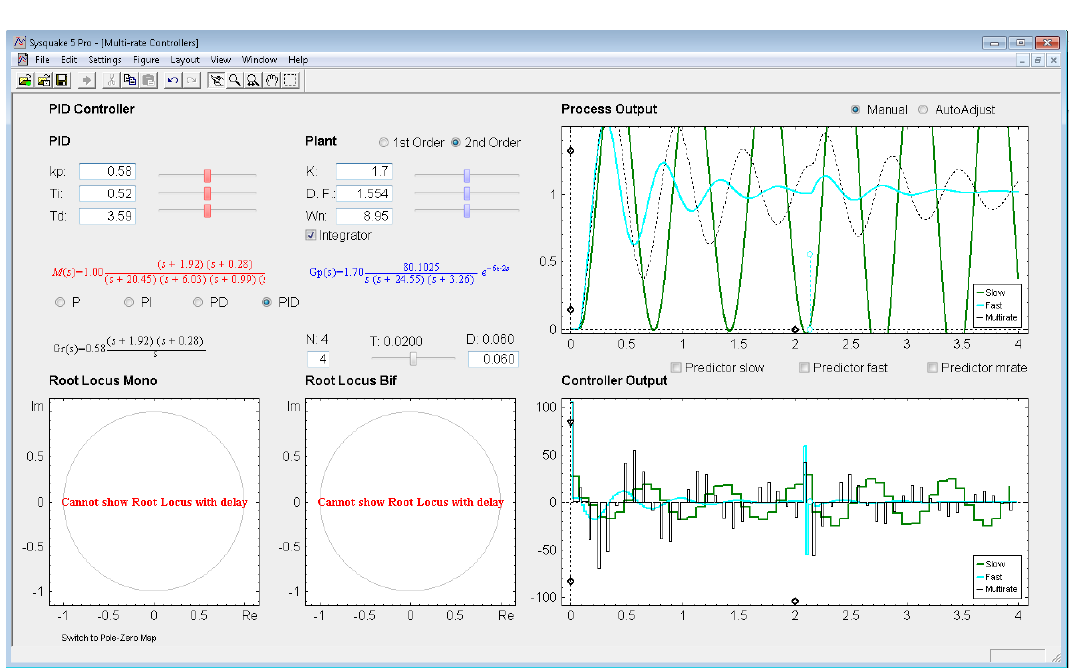
Figure 13. Application user interface for the PID controller with process time delay and no